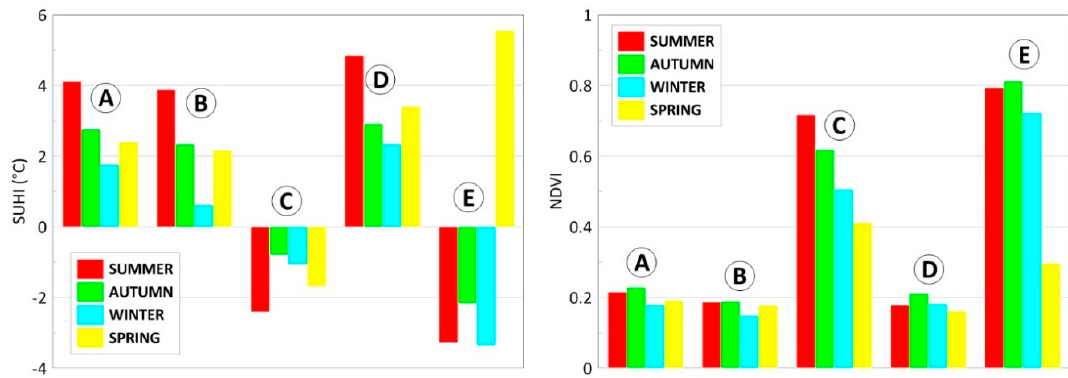
Figure 7. Variability of SUHI and NDVI at the sites A, B, C, D and E during the summer, autumn, winter and spring.